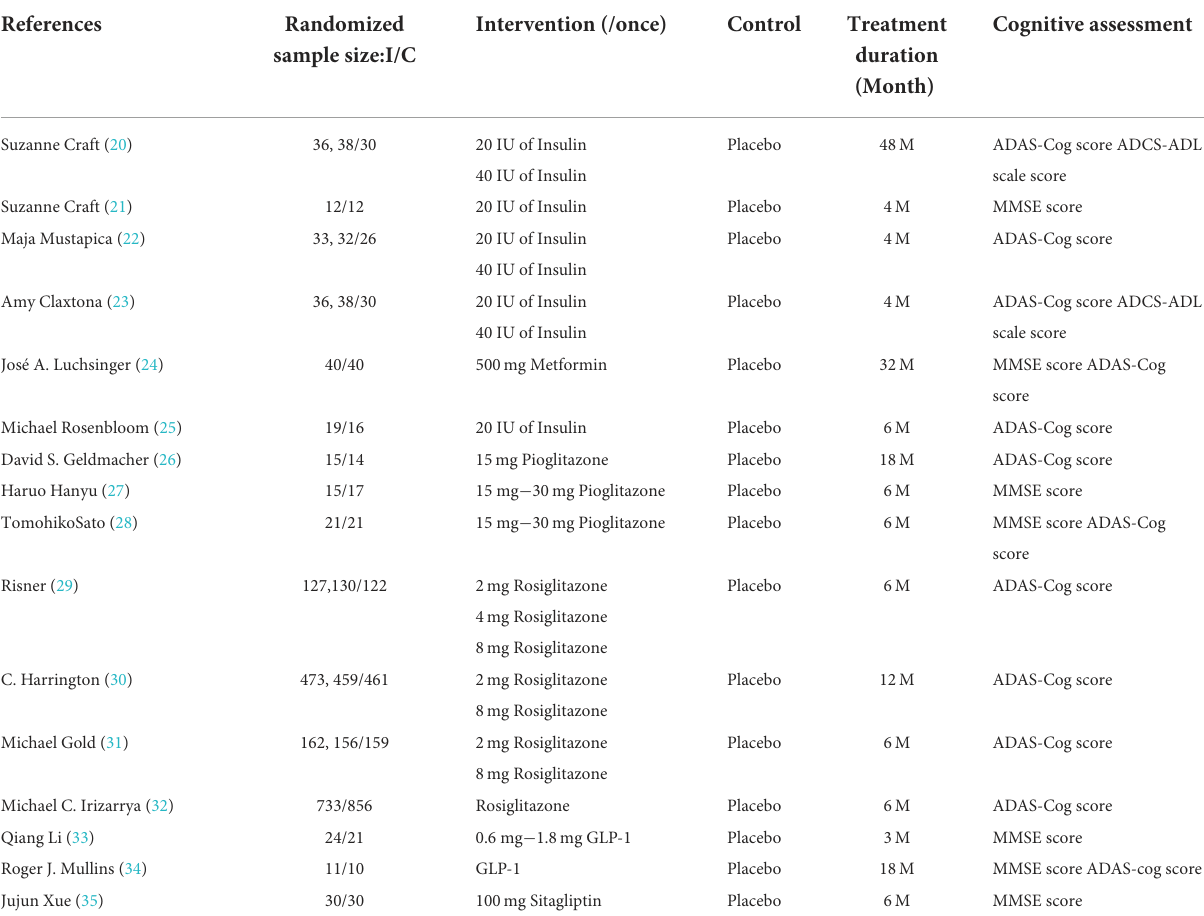
TABLE 1 The information about the included studies.